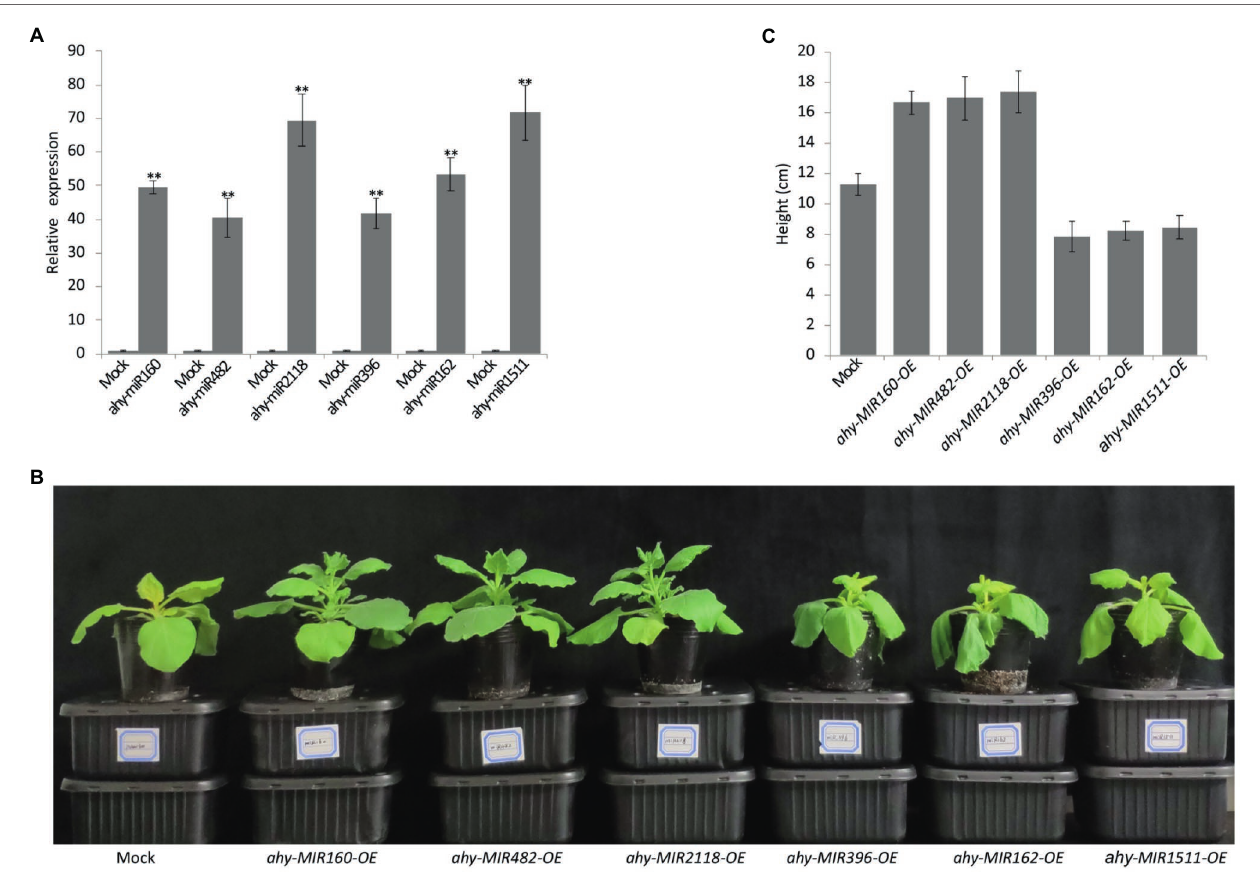
FIGURE 6 | Functional analysis of the six cold-responsive miRNAs in tobacco infiltrated by Agrobacterium tumefaciens strain GV3101. (A) The transcript analysis of peanut miRNAs in infiltrated tobacco leaves. Student’s t -test was used to determine the significance of differences between mock and the indicated lines. Asterisks indicate significant differences ( ** p < 0.01). Similar results were obtained from three biological replicates. (B) The phenotype observed in infiltrated tobacco leaves overexpressing pCAMBIA1300 and pCAMBIA1300- MIRNAs with 4 ° C treatment for 24 h. (C) The different height of infiltrated tobacco overexpressing pCAMBIA1300 and pCAMBIA1300- MIRNAs with 4 ° C treatment for 24